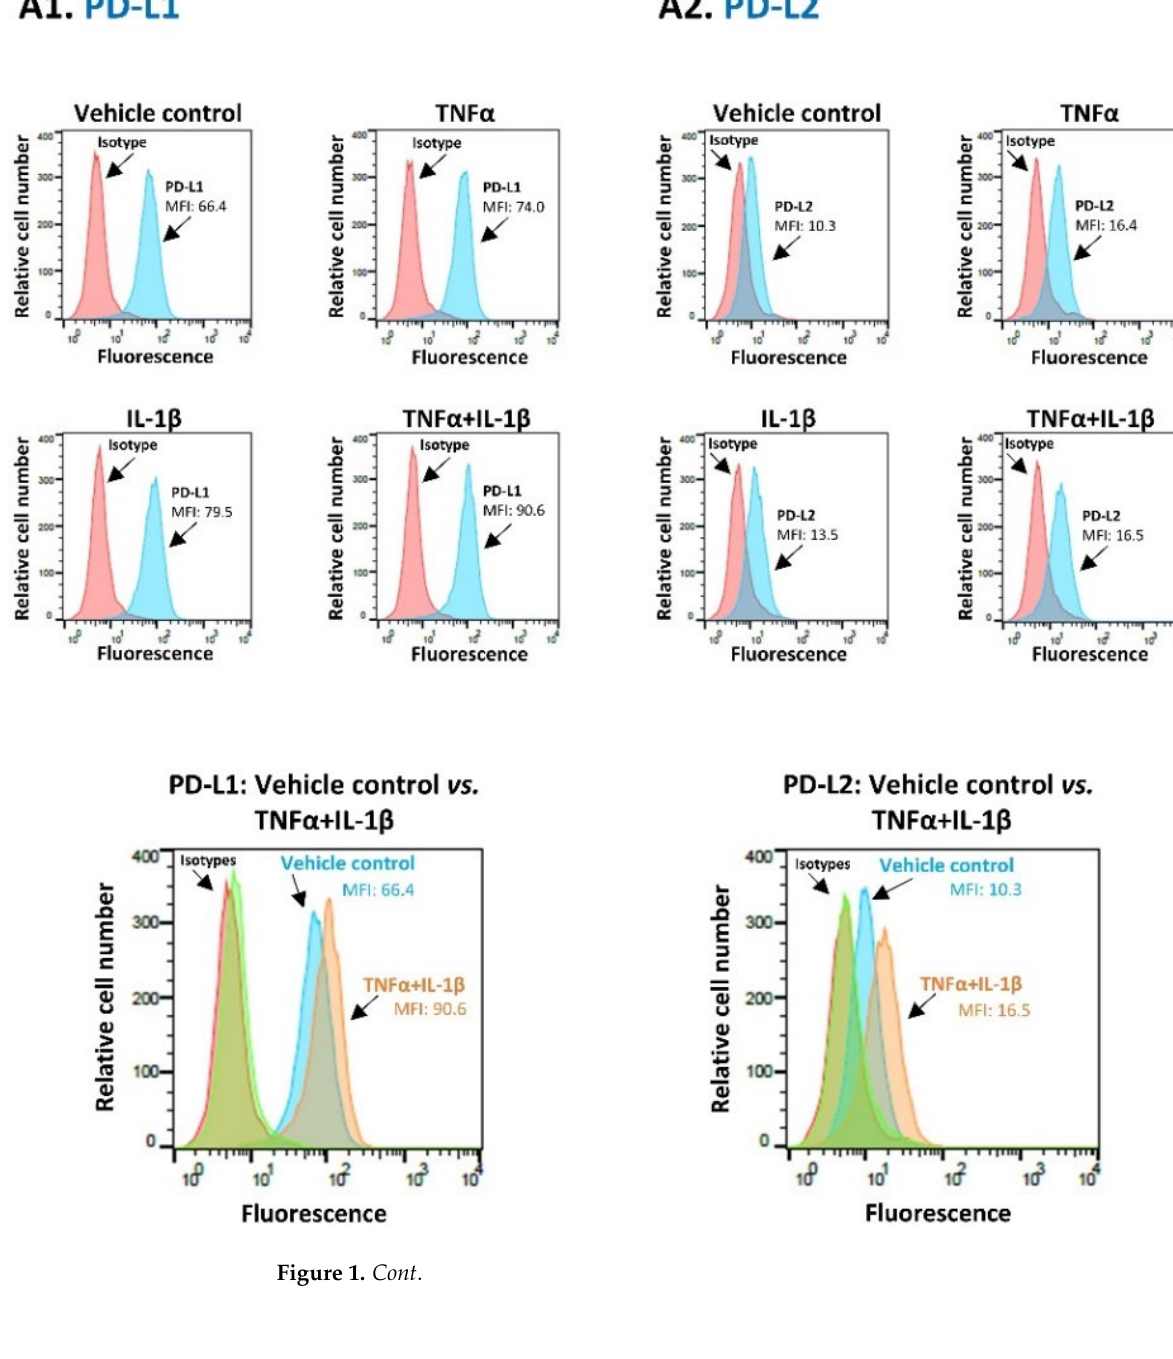
Figure 1. Joint stimulation by TNF α + IL ‐ 1 β promotes the proportion of PD ‐ L1 + PD ‐ L2 co ‐ express ‐ ing MDA ‐ MB ‐ 231 cells. ( A ) MDA ‐ MB ‐ 231 cells (MDA) were stimulated by TNF α and/or IL ‐β